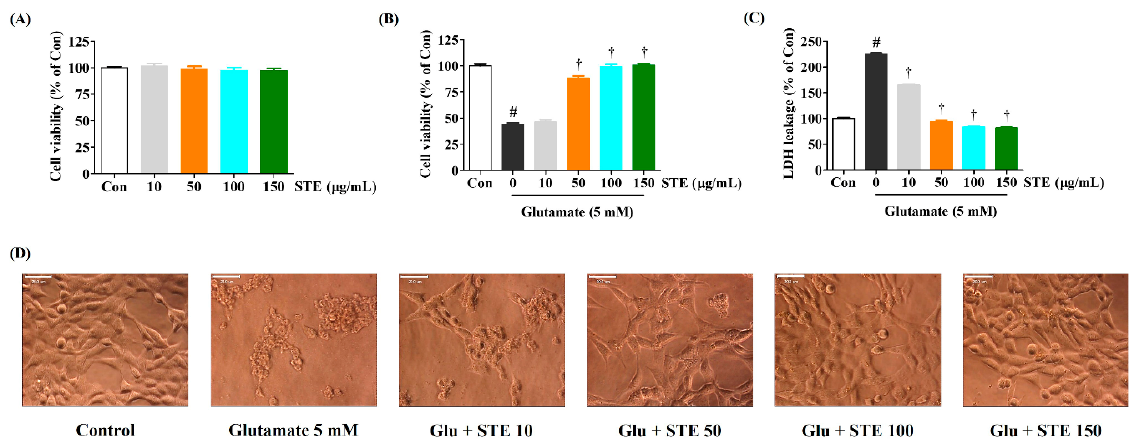
Figure 1. Effects of Selaginella tamariscina ethanol extract (STE) on glutamate-induced cytotoxicity in HT22 cells. ( A ) HT22 cells were incubated with STE concentrations of 10, 50, 100, or 150 μ g/mL. ( B – D ) After STE pretreatment concentrations of 10, 50, 100, or 150 μ g/mL, HT22 cells were stimulated with glutamate (5 mM). ( D ) Images represent the three independent experiments at a magnification of 400×. Scale bar = 20 μ m. Control cells were incubated with the vehicle alone. Data are presented as mean ± standard error of the mean of three independent experiments. Con, control; LDH, lactate dehydrogenase; Glu, glutamate. Statistical significance was defined as # p < 0.05 (vs. control) and † p < 0.001 (vs. glutamate).